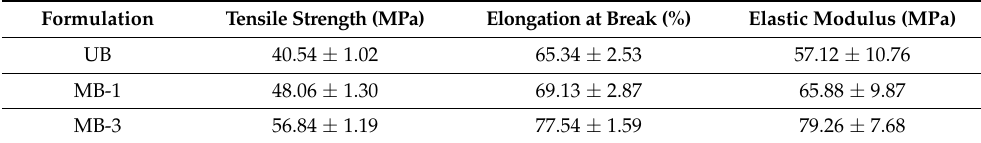
Table 3. Tensile strength values of different blend film formulations.